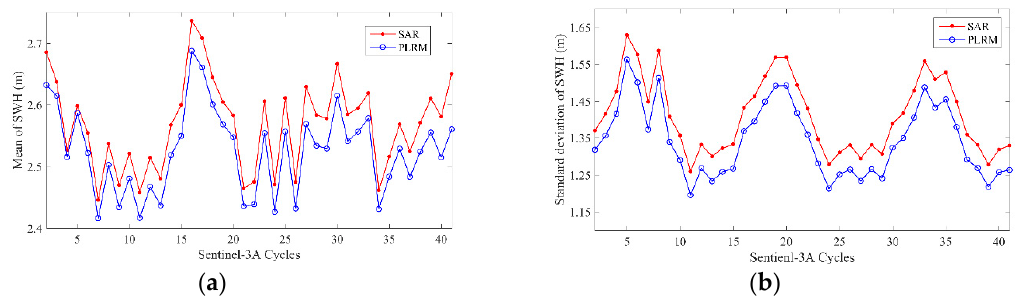
Figure 3. Cycle mean ( a ) and standard deviation ( b ) of Sentinel-3A SAR and PLRM mode SWH.